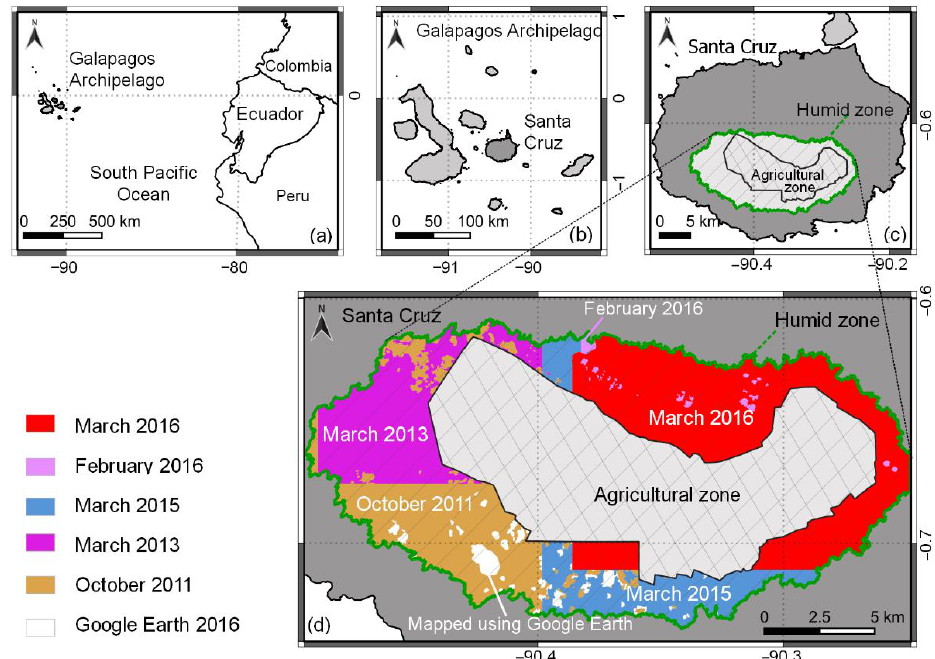
Figure 1. Study area and sources of satellite imagery. ( a ) The Galapagos archipelago with respect to mainland Ecuador in South America; ( b ) the Galapagos archipelago (dark gray represents Santa Cruz Island); ( c ) the study area in the humid zone of Santa Cruz Island (the green line delimits the extent of the humid zone; the central polygon with a black border and inner crossed lines represents the agricultural zone); ( d ) satellite imagery sources used for the very-high-resolution mapping in this study. The area mapped using WorldView-2 (WV-2) satellite imagery captured in March 2016 is shown in red, February 2016 in pink, March 2015 in blue, March 2013 in purple, October 2011 in ocher, and white spots represent areas covered with clouds, which were mapped using Google Earth (GE) satellite imagery captured in March 2016.